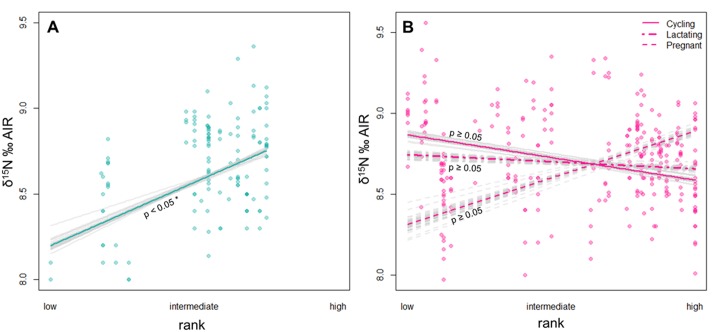
Model results for the effect of social dominance rank on the δ15N values in male (A) and female (B) bonobos.Rank had a significant effect on δ15N values in males, but not in females. Model stability is indicated by the grey alternative model lines, suggesting some influence of single hair samples and individuals which did not influence our overall results.